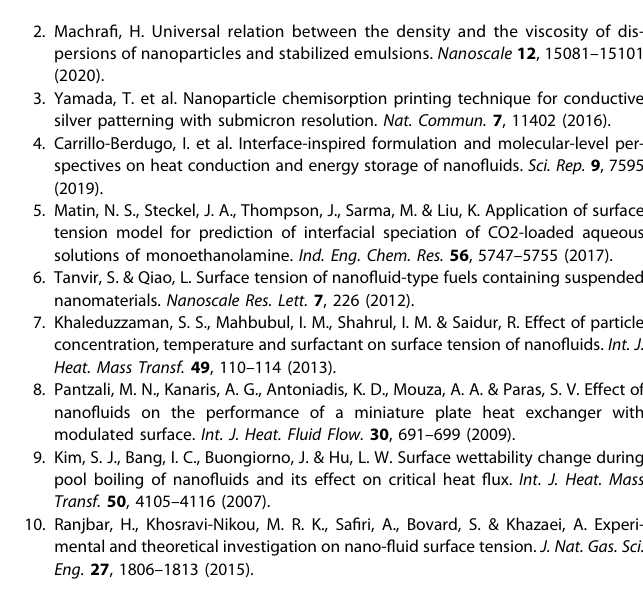
Fig. 5 Mapping of surface tension behaviour. a Competition of key parameters H NO j j , D p and D p H NO for the nanoparticle dispersions SiO 2 - W ( 1 ), Al 2 O 3 -W ( 2 ), B-D ( 3 ) and Lap-W ( 4 ) for two volume fractions: φ = 0.005, φ = 0.01. Note that for a better visualisation both the values of D H φ = 0.005, φ = 0.01, respectively. b All the considered D p and p NO for only the Lap-W system have been divided by 5 and 2 for the cases nanoparticle dispersion systems are resumed in a K p − K Σ map, representing fi ve observed γ -vs- φ behaviours: “ signi fi cantly constant ” where the change (proven to be mathematically an increase) in γ is not observable (less than 1%) on the 1 mN/m range, “ strictly increasing ” where γ > 0 over any φ -range, “ distinct minimum ” where a clear minimum is visible at operating φ ranges, “ virtually decreasing ” where ∂ γ < 0 at ∂ φ φ operating φ ranges and “ stronger decrease ” where ∂ φ γ decreases distinctly steeper than the previous case. It is to be reminded that the latter three cases are distinguished within the φ -range under which typical nanoparticle dispersions are used. Moreover, the latter two cases are conceptually the same but are distinguished for application or engineering purposes: much higher adsorption kinetics and/or smaller nanoparticles induce (although theoretically having the same tendency) for the observer a decrease that is much steeper and occurs at much lower nanoparticle concentrations, which justi fi es to make a distinction between them. The colours indicate qualitatively the transition from one region to another, whereas the model gives two mathematical limits: the limit K p K Σ = 1 (red dashed line) designates formally the crossover from ∂ φ γ | ∀ φ > 0 to ∂ φ γ | φ → 0 < 0, while the limit K Σ ¼ 1 þ 1 (blue dashed line) stands for the crossover from ∂ φ γ | φ → 0 < 0 to ∂ φ γ | ∀ φ < 0. K p Interestingly, b shows that the dispersions seem to correspond to sets of simultaneously increasing K p and K Σ , indicated by the left-to-right diagonally up-going set of points. This con fi rms the link between K p K Σ and the behaviour of the surface